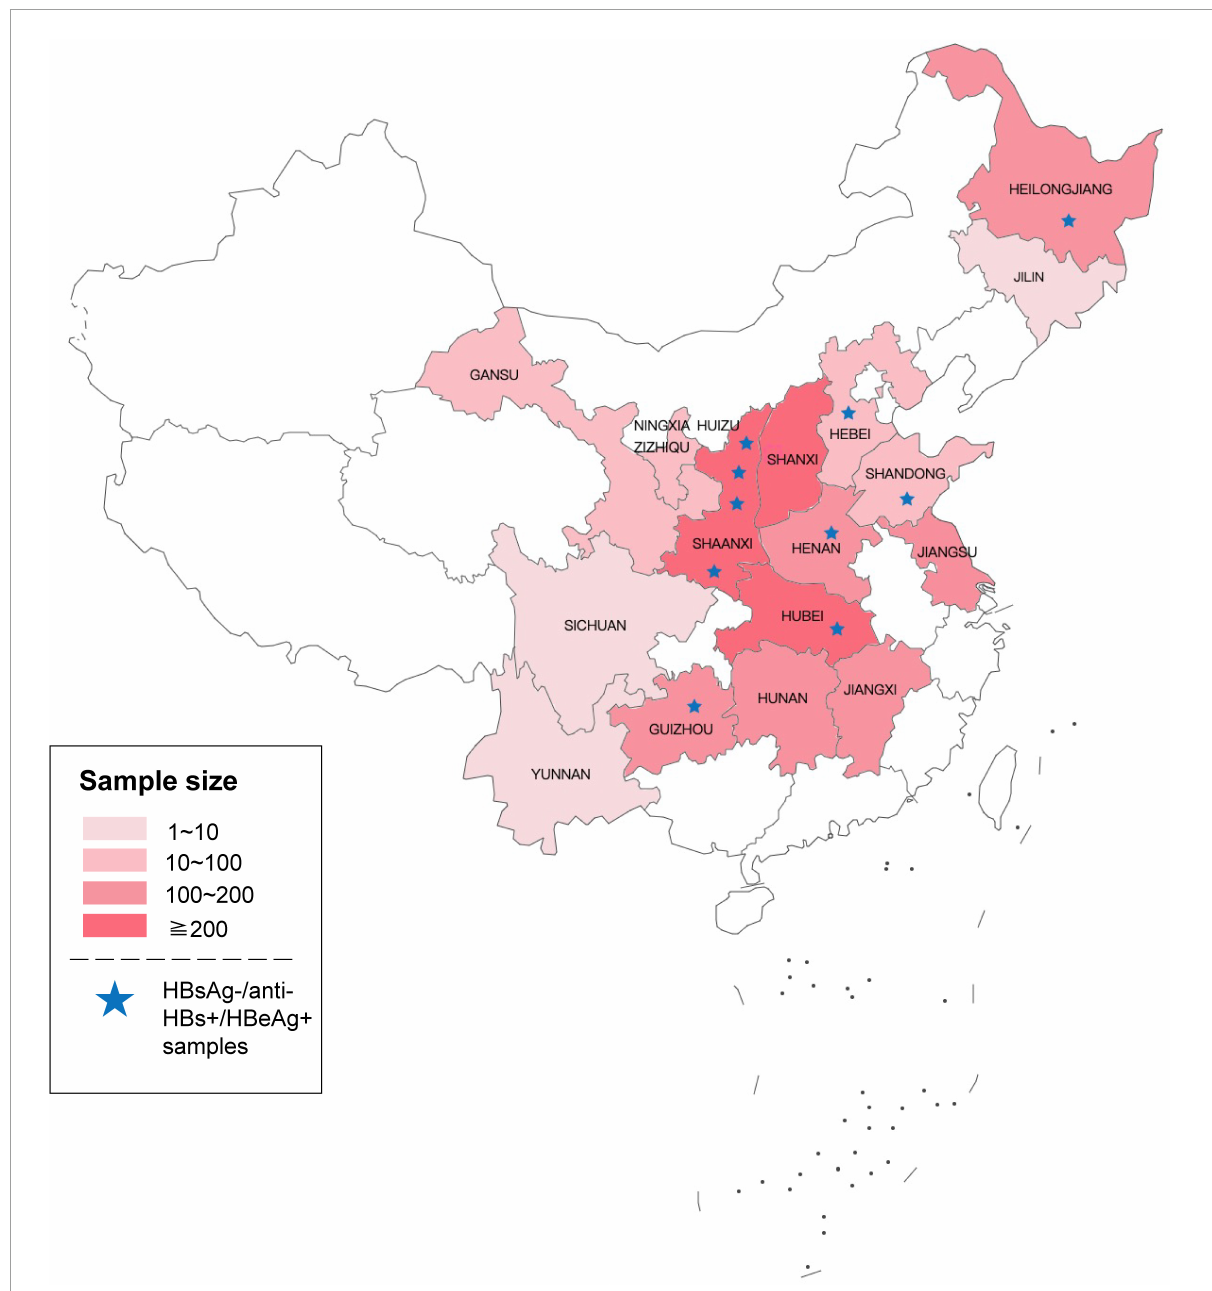
FIGURE1 Geographical distribution of the 2022 samples that preliminary screened reactive for HBV DNA and non-reactive for HBsAg. Asterisks represent HBsAg-/anti-HBs+/HBeAg+ samples tested by ARCHITECT reagents (The original map is from the Map World of National Platform for Common Geospatial Information